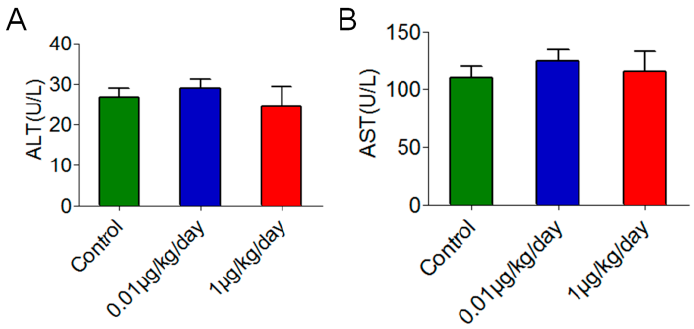
Figure 3. Serum levels of alanine aminotransferase (ALT) and aspartate aminotransferase (AST) in the control and low-dose OP treated mice. ( A ) There was no significant difference in serum levels of ALT in mice after OP treatment. ( B ) There was no significant difference in serum levels of AST in mice after OP treatment.